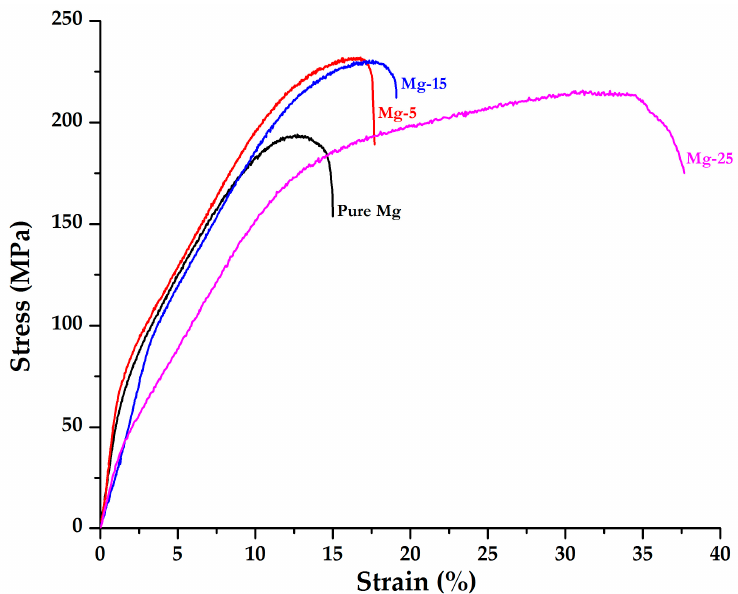
Figure 3. Engineering stress-strain curves of pure Mg and the synthesized Mg/GMB syntactic foams during compressive loading.